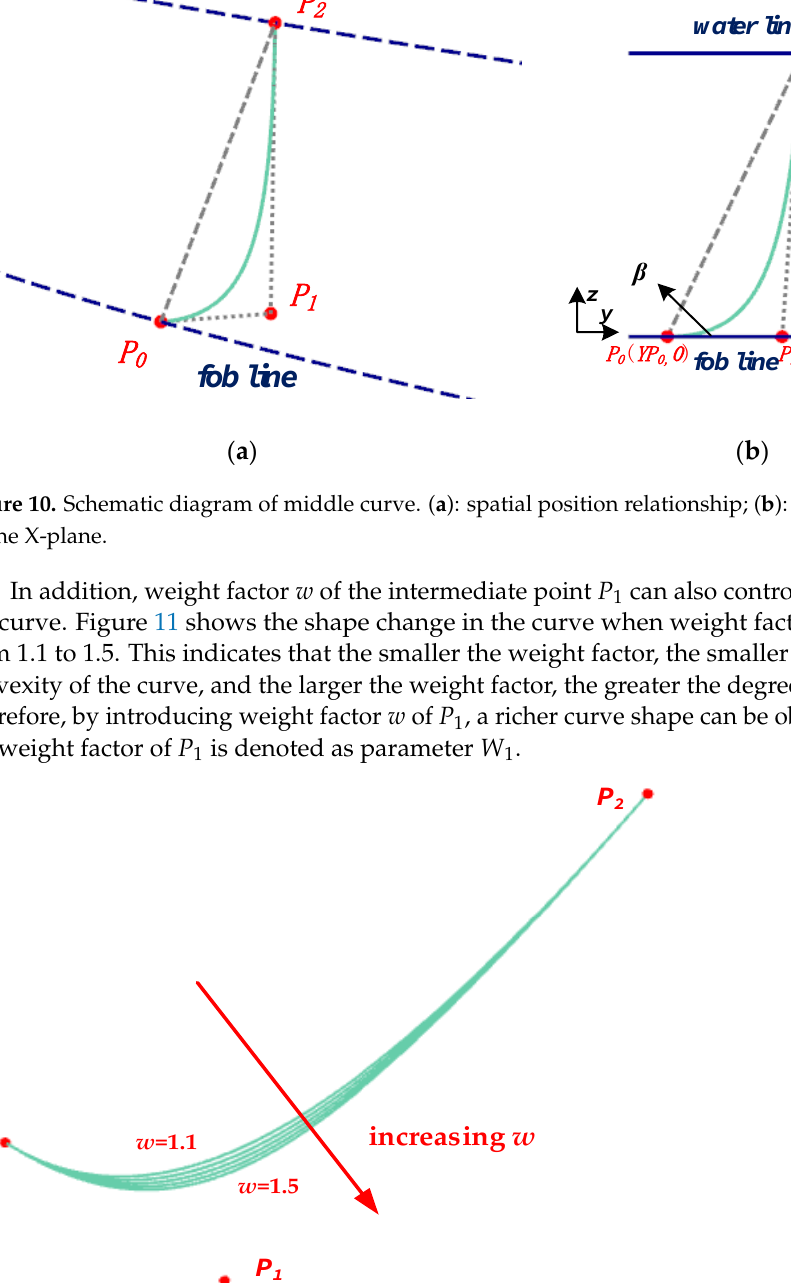
( b ) Figure 12. Schematic of the upper curve. ( a ): spatial position relationship; ( b ): shape of the curve on the X-plane. With the above analysis, the geometric problem is transformed into an attempt to find a NURBS curve starting from point P 2 with starting angle α to angle δ reaching P 5 .